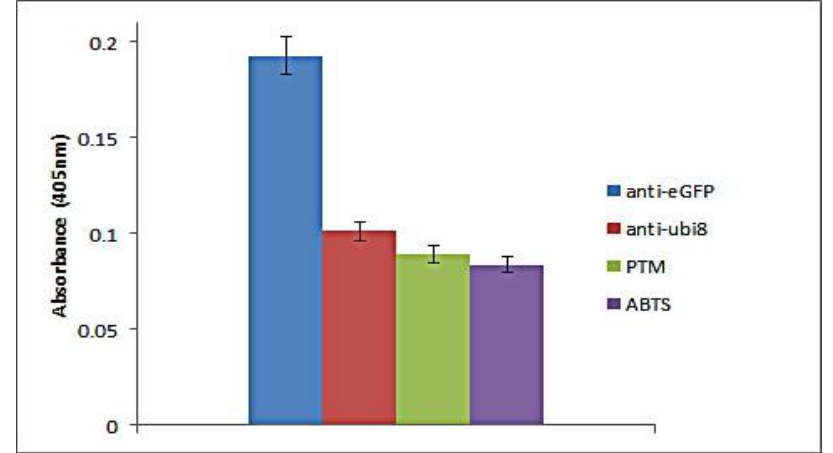
Figure 3. Absorbance analysis of the probe based direct assay for antibody antigen reaction. Reaction time was 30 min with ABTS (1 µg/mL) and H expressed as the average of three independent measurements ( n =